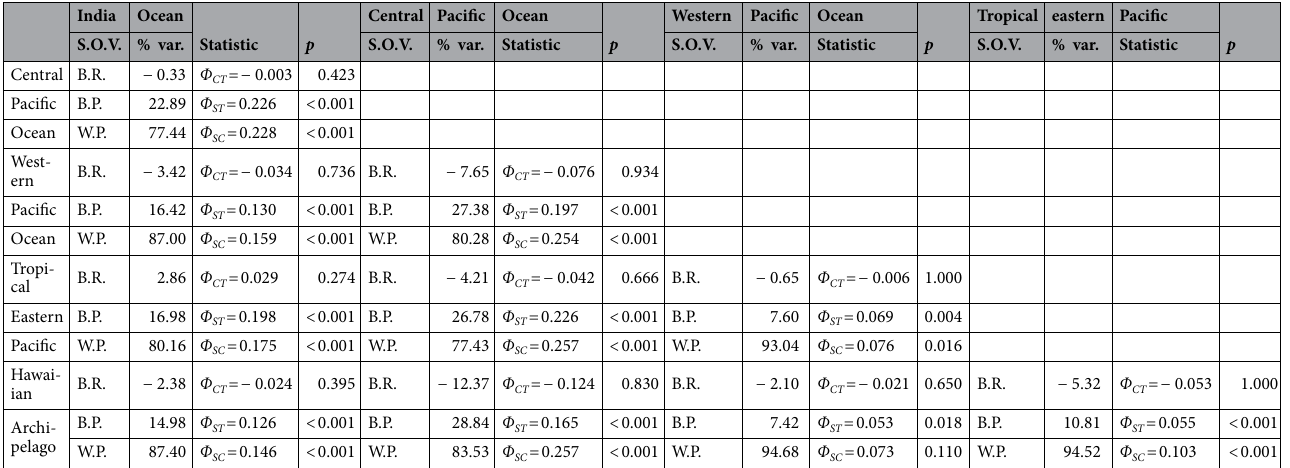
Table 6. Between region pairwise AMOVA of mtDNA Tamura and Nei 31 distances in Echinothrix diadema. S.O.V. source of variation, B.R. between regions, B.P. between populations within regions, W.P. within populations, % var . percentage of variation. n.b. Tropical eastern pacific = Clipperton Island + Isla del